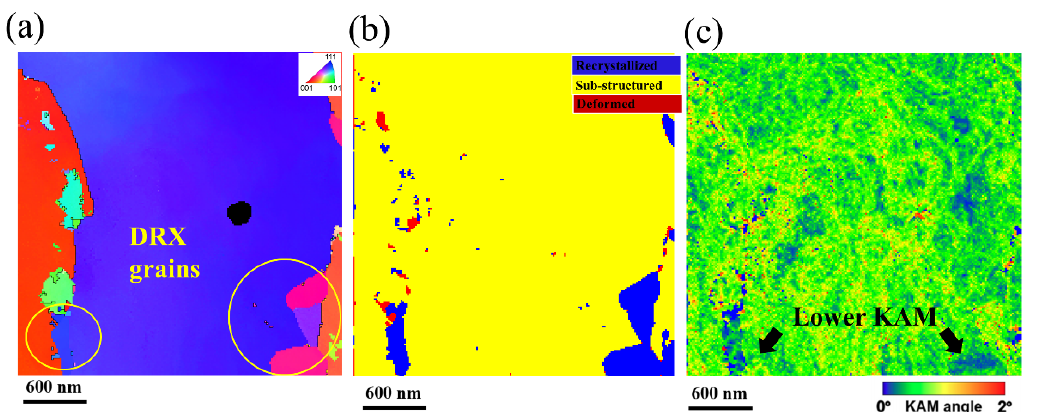
Figure 15. ( a ) TKD images of the as-received sample; ( b ) recrystallized fraction component map showing the process-induced deformed, sub-structured, and recrystallized grains; ( c ) the formation of recrystallized grains consumes dislocations.